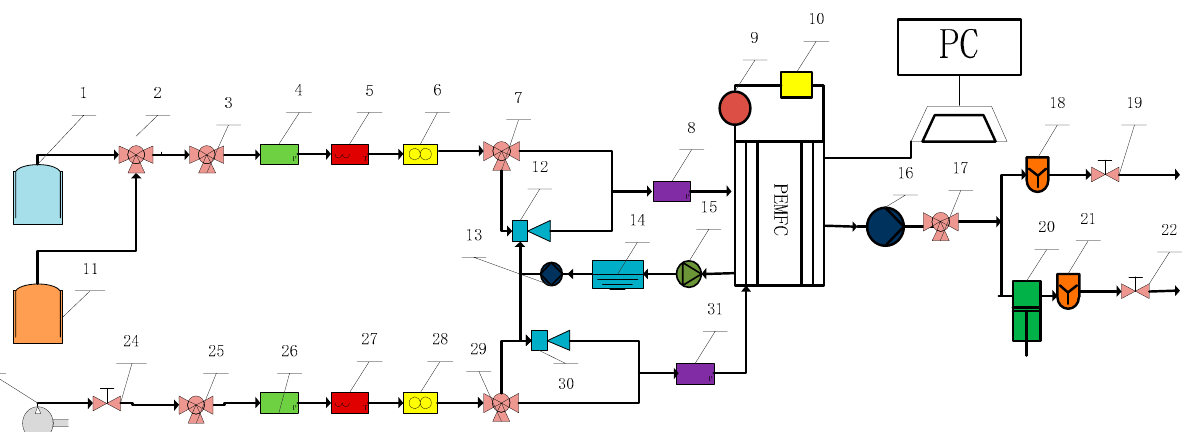
Figure 2. Experimental setup: 1—hydrogen cylinder, 2—pressure reducing valve, 3—pressure regulating valve, 4—pressure sensor, 5—temperature sensor, 6—hydrogen flow meter, 7—proportional valve, 8—differential pressure sensor, 9—electronic load, 10—AC impedance tester, 11—nitrogen cylinder, 12—humidifier, 13—radiator, 14—de-ionized water tank, 15—water pump, 16—hydrogen concentration sensor, 17—solenoid valve, 18—safety alarm device, 19—electromagnetic exhaust valve, 20—hydrogen recovery device, 21—safety alarm device, 22—electromagnetic exhaust valve, 23—air pump, 24—electromagnetic exhaust valve, 25—pressure reducing valve, 26—pressure sensor, 27—temperature sensor, 28—oxygen flow meter, 29—proportional valve, 30—humidifier, 31—differential pressure sensor.